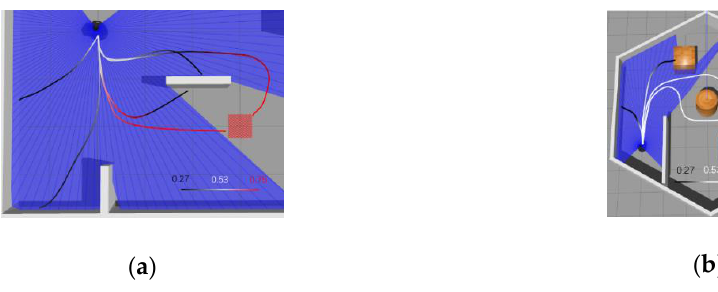
Figure 6. Matching network output changes on different paths: ( a ) matching network (MN) output under Pre-MAP and ( b ) MN output under new map without